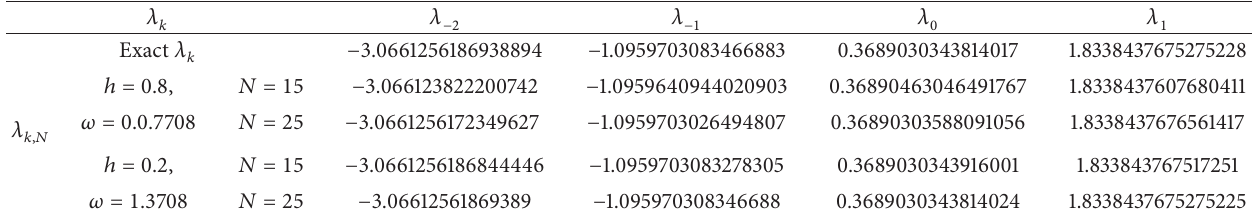
Table 4: The approximation 𝜆 𝑘,𝑁 and the exact solutions 𝜆 𝑘 for different choices of ℎ and 𝑁 .